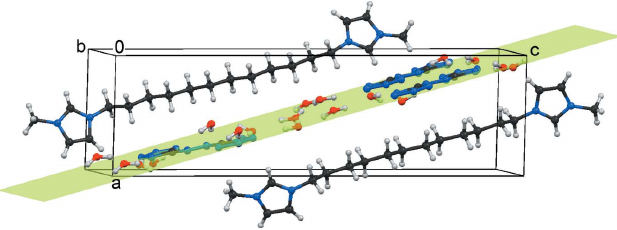
Figure 2 Arrangement of cations above and beneath the plane of anions and water molecules in the unit cell of the title compound.